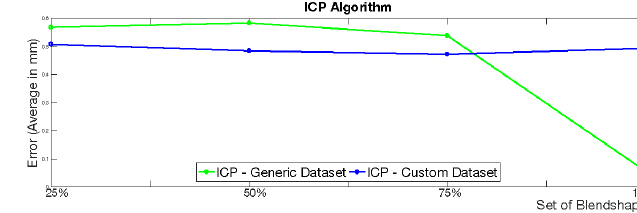
Fig. 16. Graph showing the error difference between the generic dataset and customized dataset processing for the Euclidean Distance algorithm.